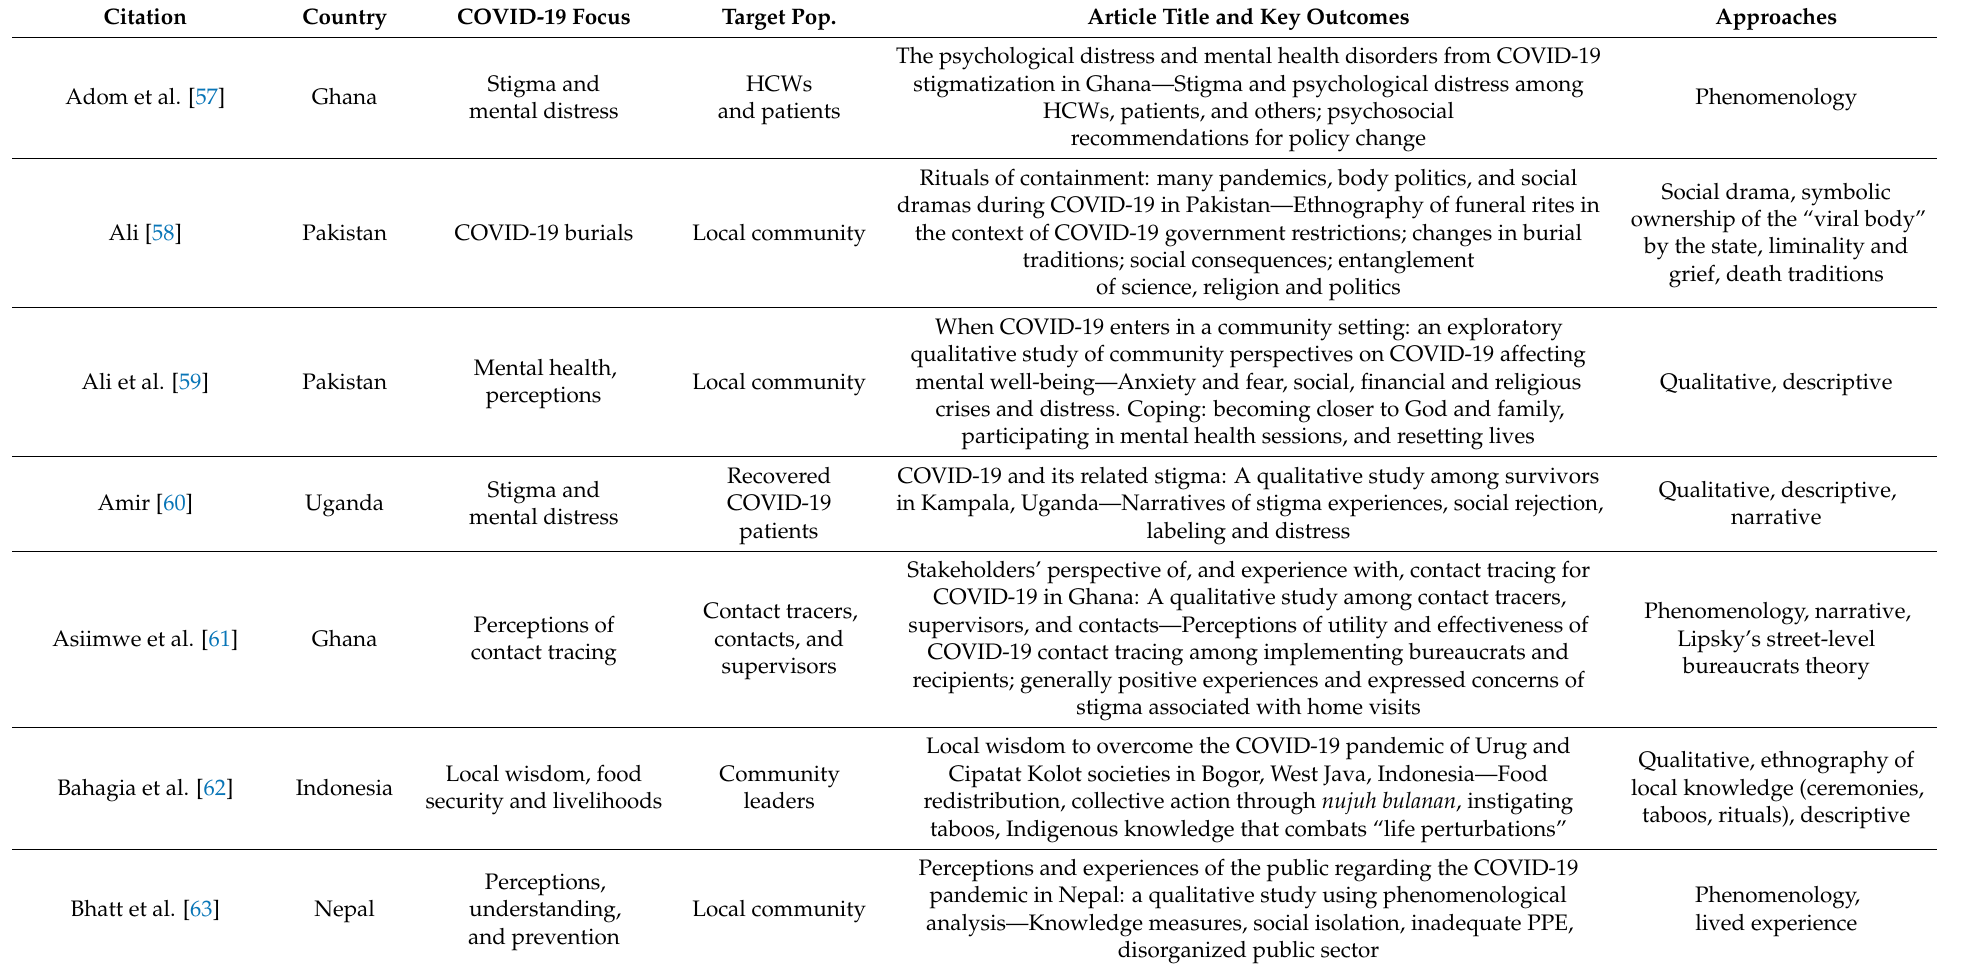
Table 2. Twenty-five community-based studies included in the literature